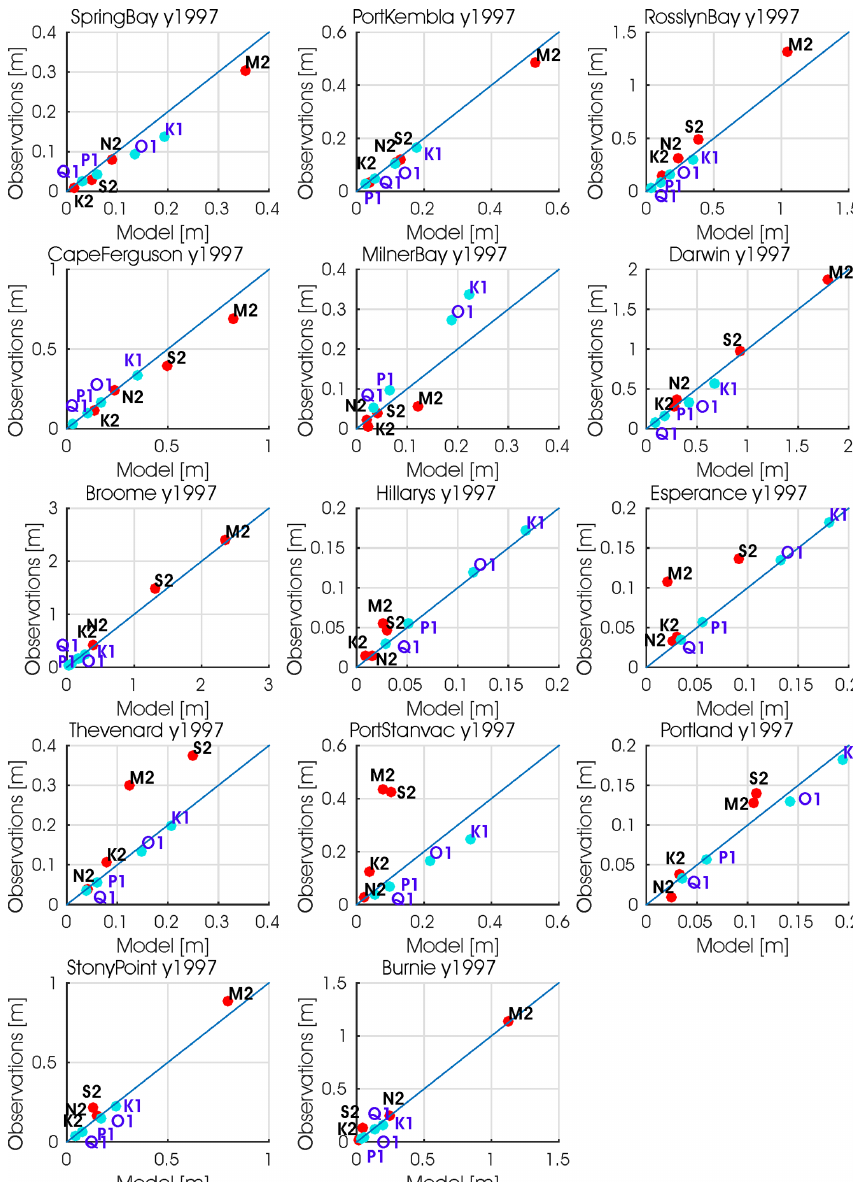
Figure 2. Comparison of the eight major tidal constituents estimated from observations and modelled for the tide gauge locations shown in Fig. 1. Red (blue) dots denote the semi-diurnal (diurnal) tidal constituents